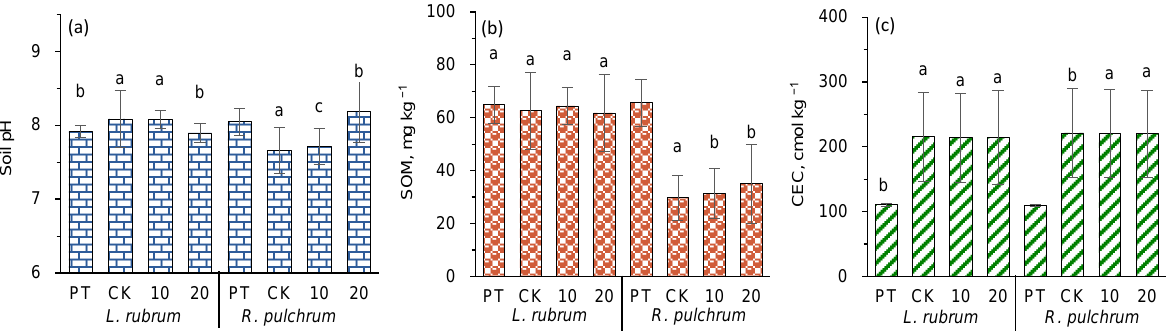
Figure 3. Effects of planting ornamental plants and applying IAA on ( a ) soil pH, ( b ) SOM, and ( c ) soil CEC. Different letters indicate significant differences among the treatments, p < 0.05. The posthoc test was performed with Tamhane method. PT indicates samples of pre-treatment, while CK, 10, and 20 are IAA treatments at 0, 10, and 20 mg L −1 , respectively. Compared to PT, the average soil pH in CK was significantly decreased by 0.40 units